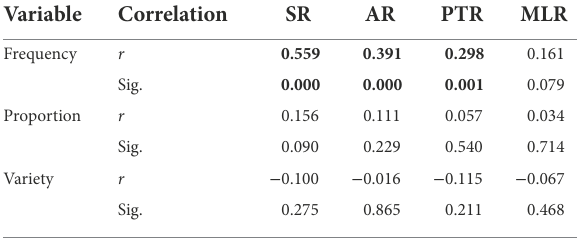
TABLE 1 Descriptive statistics of the variables: FSs and oral fluency. TABLE 2 Correlations between FSs and speed